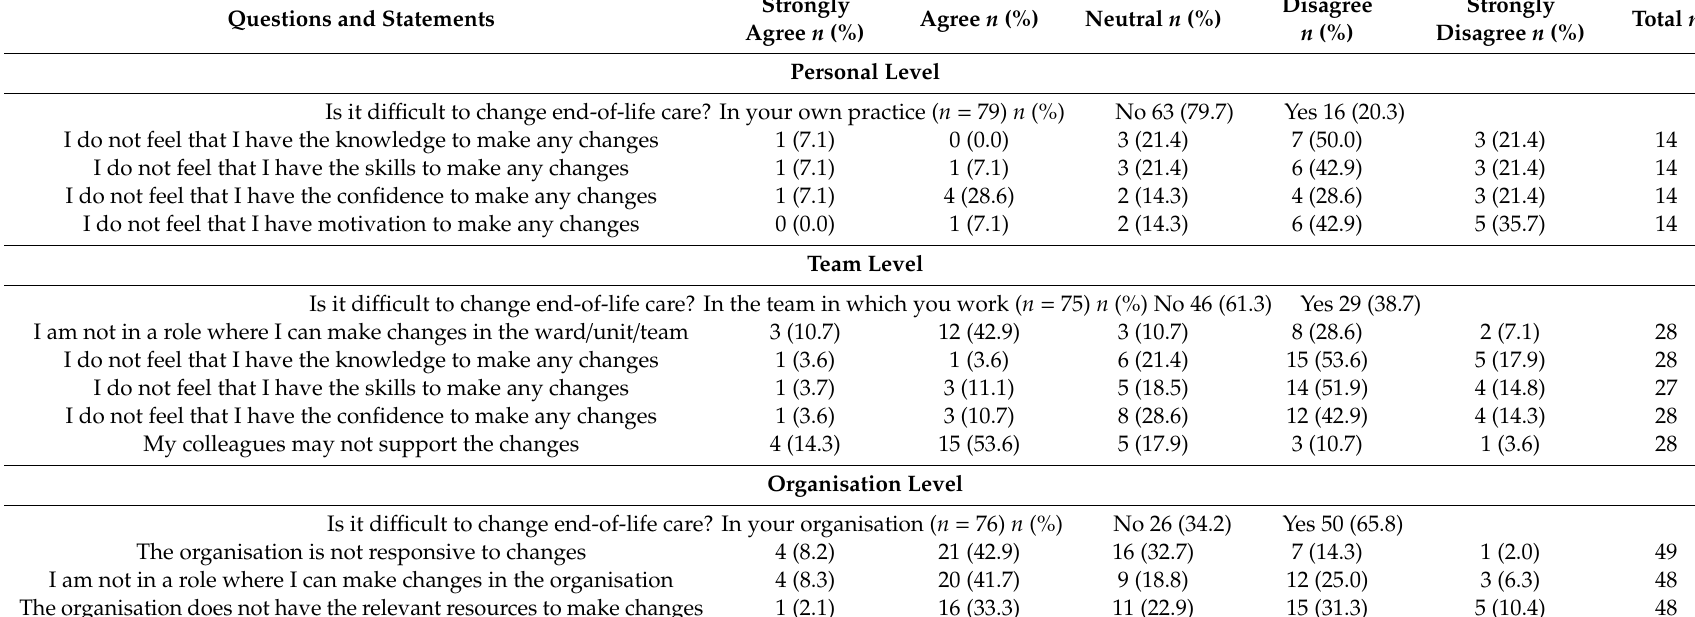
Table 4. Self-reported barriers to practice changes at personal, team and organisation